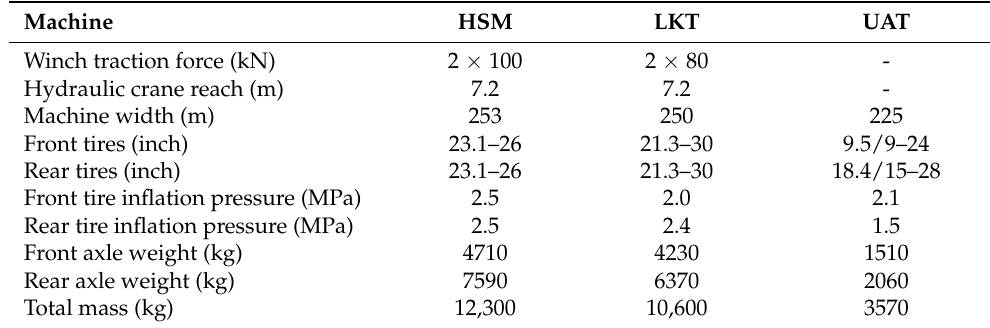
Table 2. Basic parameters of the used machines